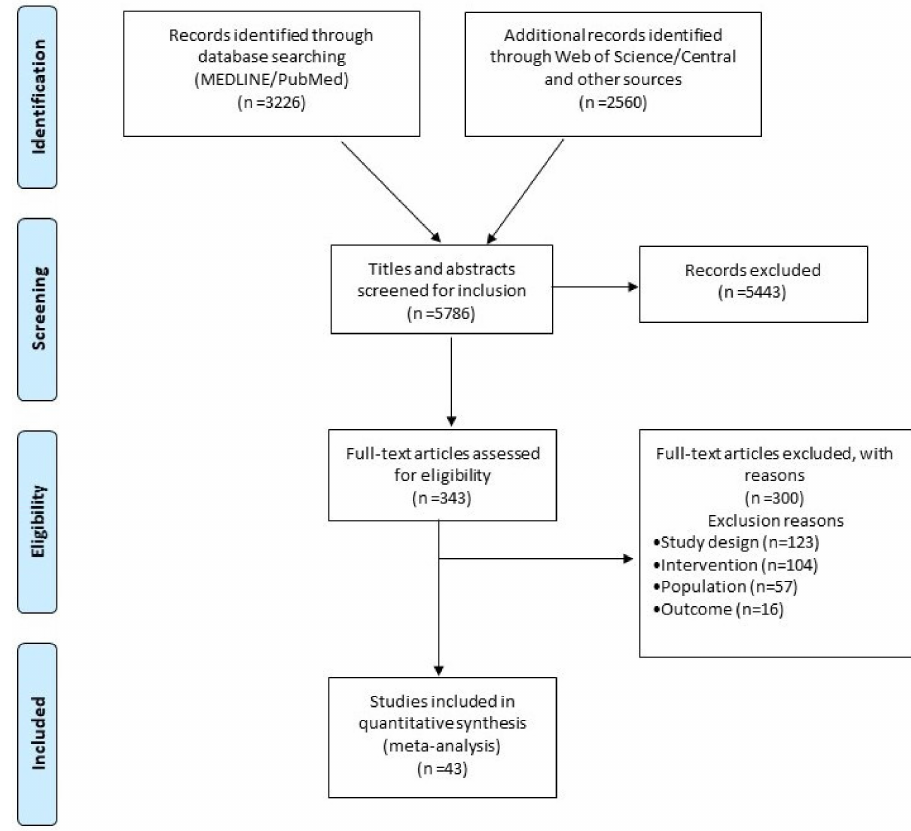
Figure 1. Prisma Flow chart